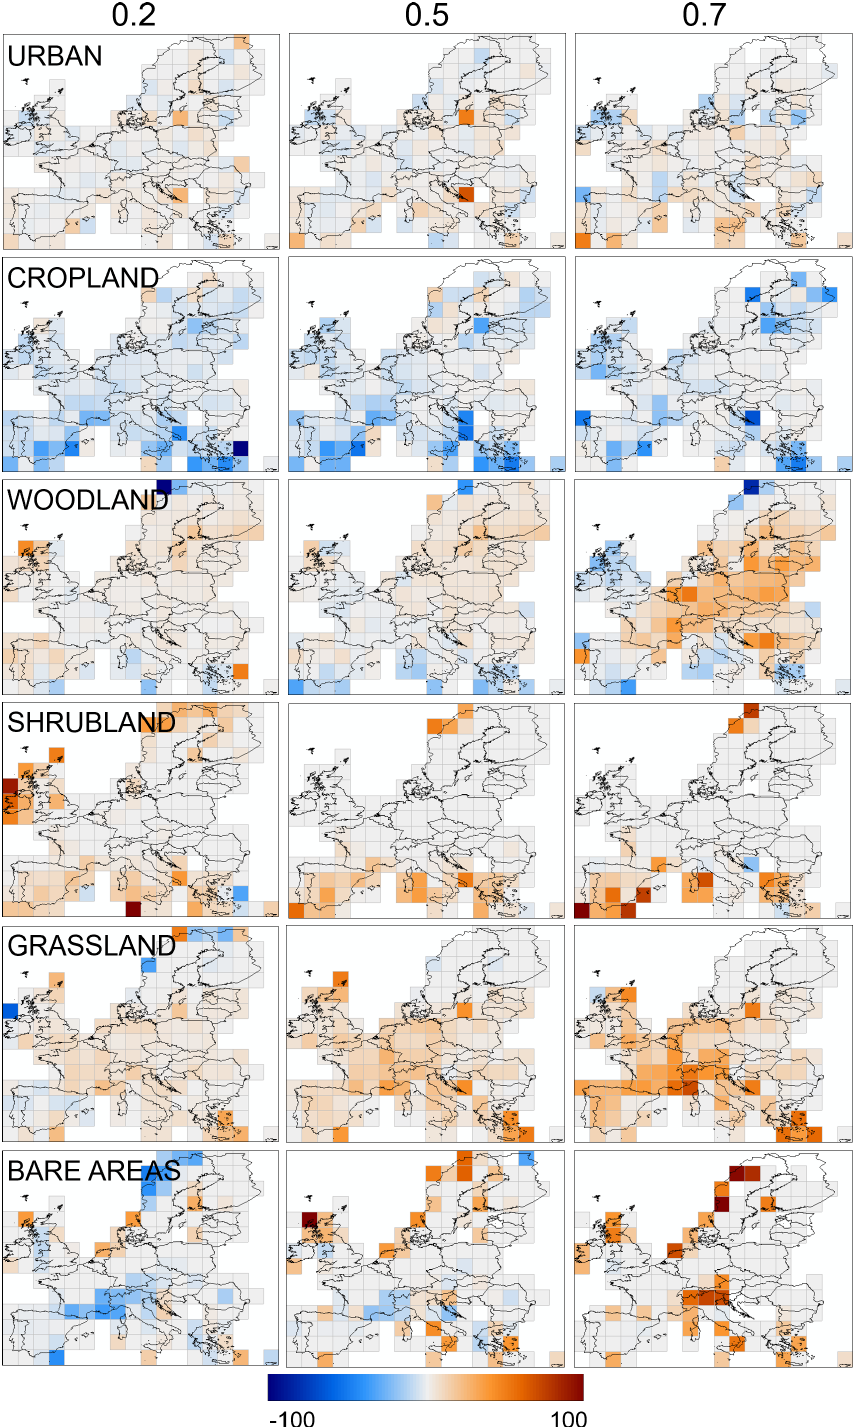
Figure 9. Comparison between the PA for LANDMATE PFT and ESA PFT. The plots show the differences between the PA, where the positive values mean a higher PA of LANDMATE PFT and the negative values a higher PA of ESA POULTER PFT. The differences were calculated per 2.5 ◦ grid cell of the auxiliary grid as introduced in Sect. 4.1 for each LULC type of the 0.2 group (left column), the 0.5 group (middle column) and the 0.7 group (right